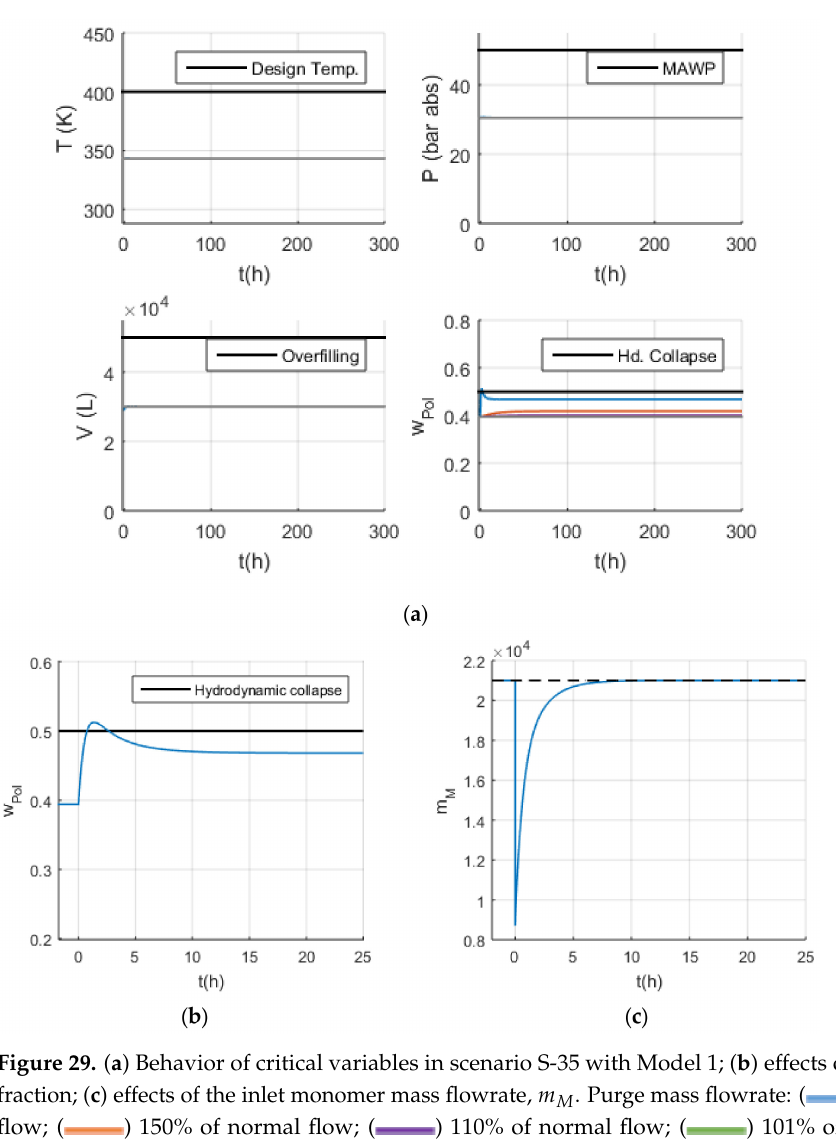
Figure 29. ( a ) Behavior of critical variables in scenario S-35 with Model 1; ( b ) effects of the polymer fraction; ( c ) effects of the inlet monomer mass flowrate, m M . Purge mass flowrate: (